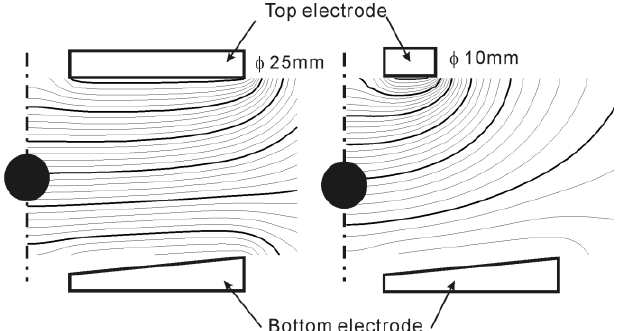
Figure 4. Electric field between the top and bottom electrodes obtained by a numerical analysis. The diameter of the top electrode was decreased from 25 mm (left) to 10 mm (right) [20].